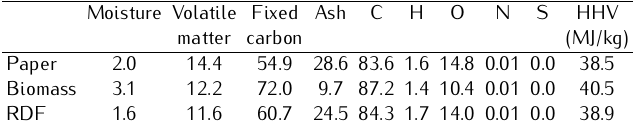
Table 4. Fuel Properties of Char Products